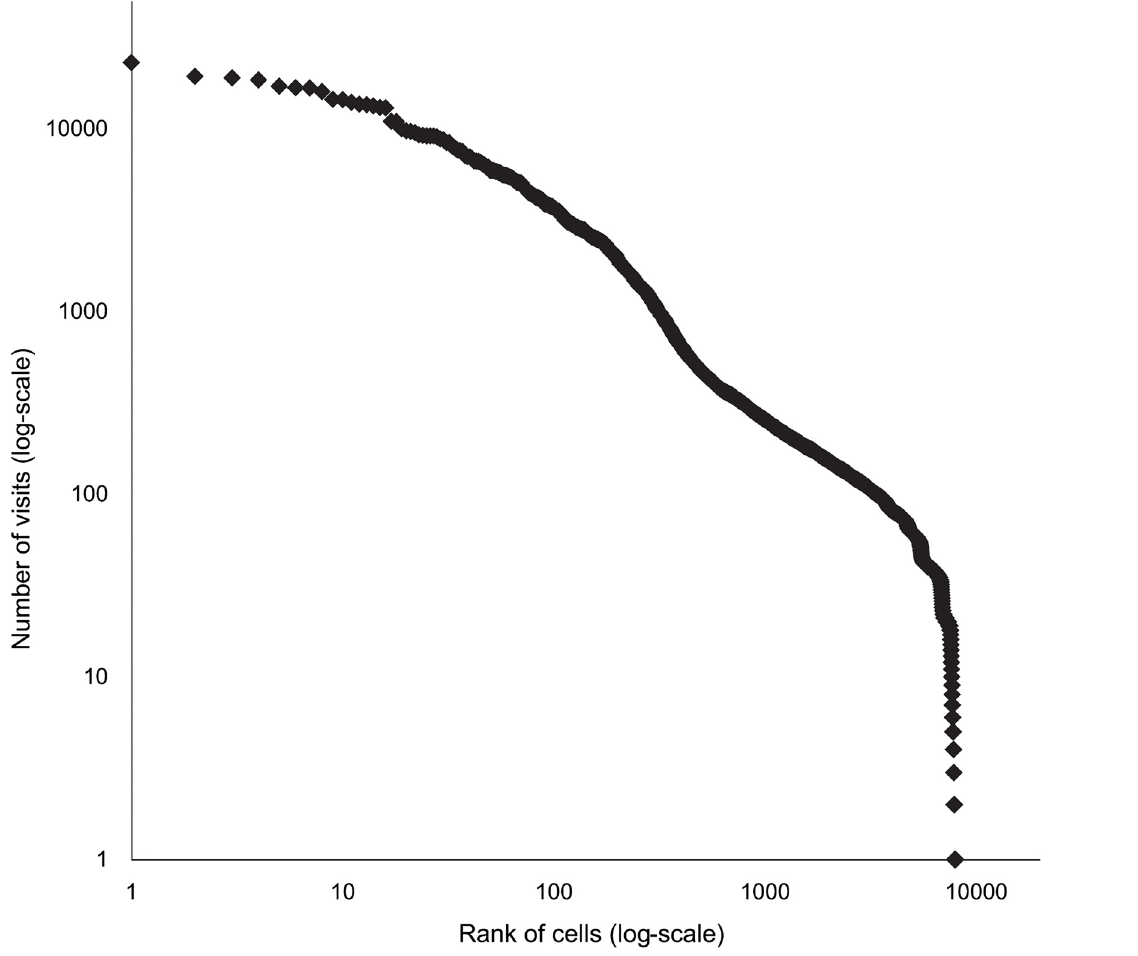
Fig 5. Rank size distribution of visit per cell over a month (model